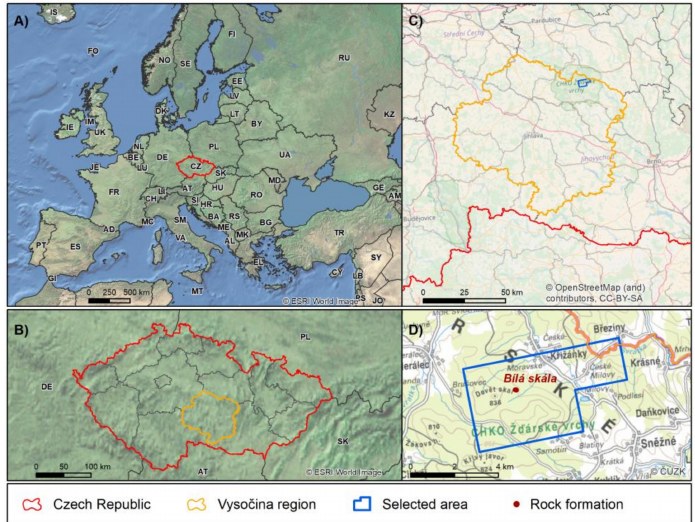
Figure 4. Overview map of study site in several dimensions: ( A ) in Europe; ( B ) in the Czech Republic; ( C ) in the Vysoˇcina region; ( D ) the processed area with the placement of the 3D object B í l á sk á